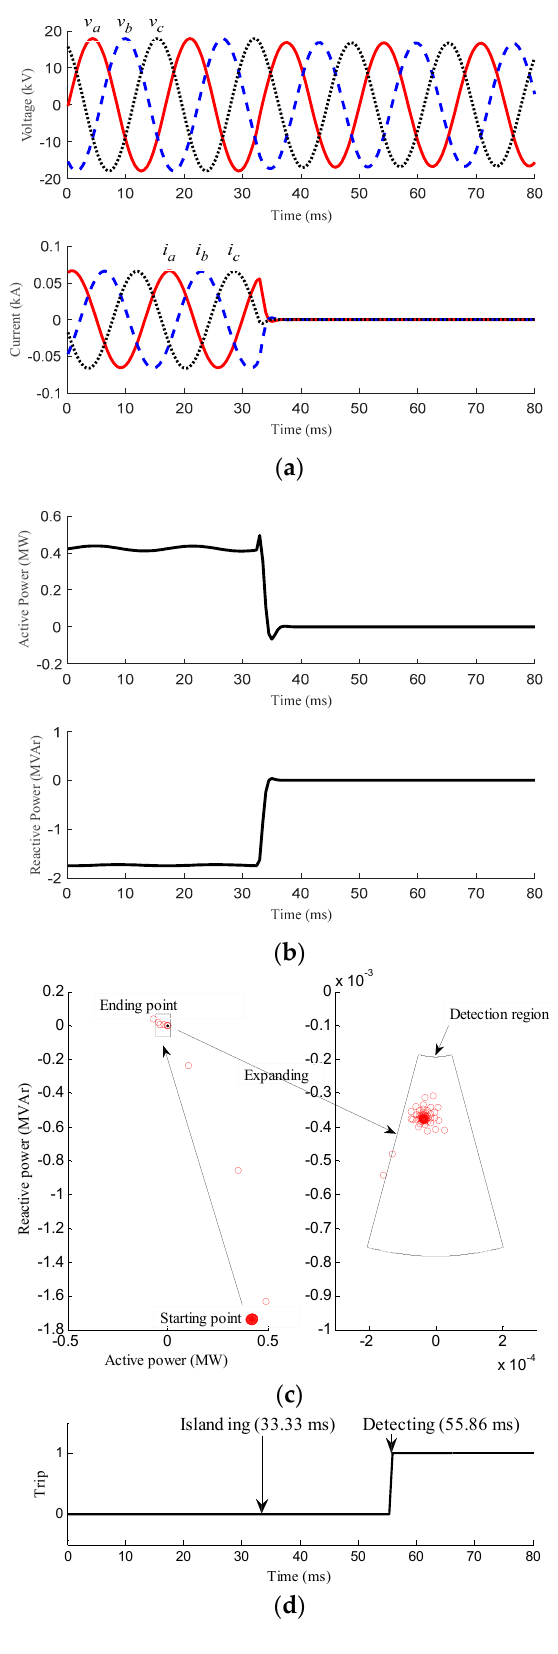
Figure 5. Results for Case 3. ( a ) v a , b , c (upper) and i a , b , c (lower); ( b ) p 3 ph (upper) and q 3 ph (lower); ( c ) Trajectories of the point ( p 3 ph , q 3 ph ); ( d ) Islanding detection signal.